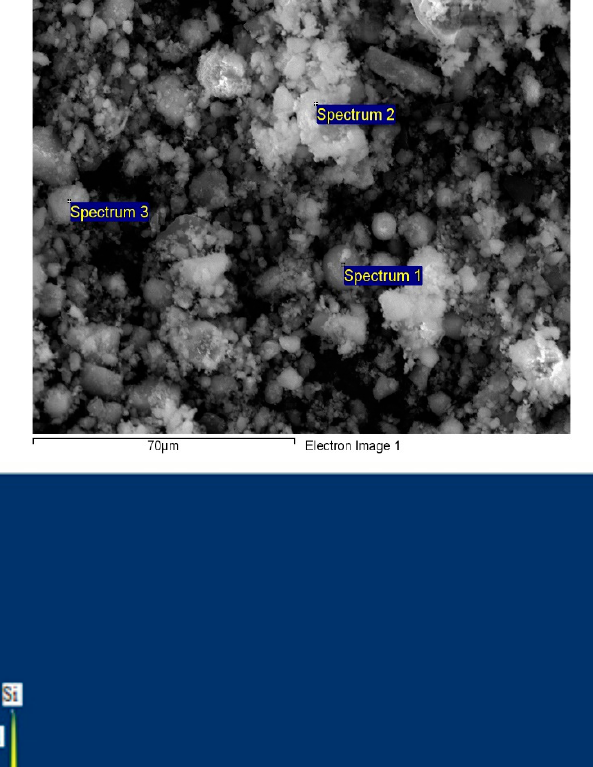
Table 2. Elemental analysis of FA and FA/Fe 3 O 4 , mass %.